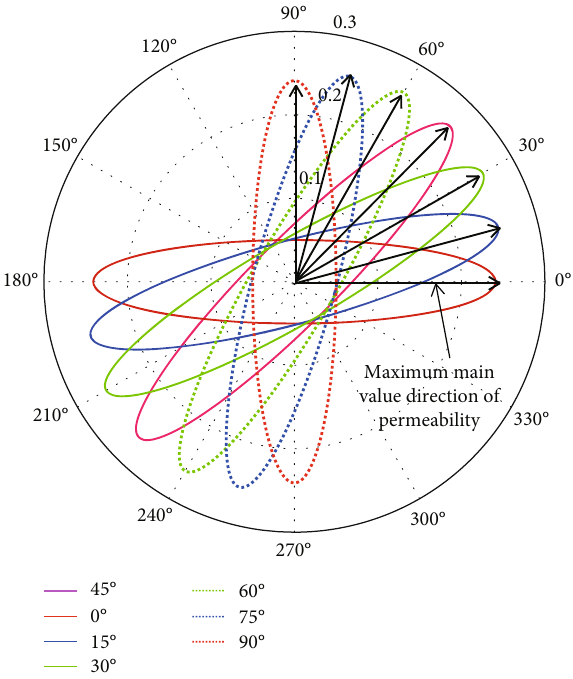
Figure 19: Anisotropic permeability tensor vs. fracture angle change.